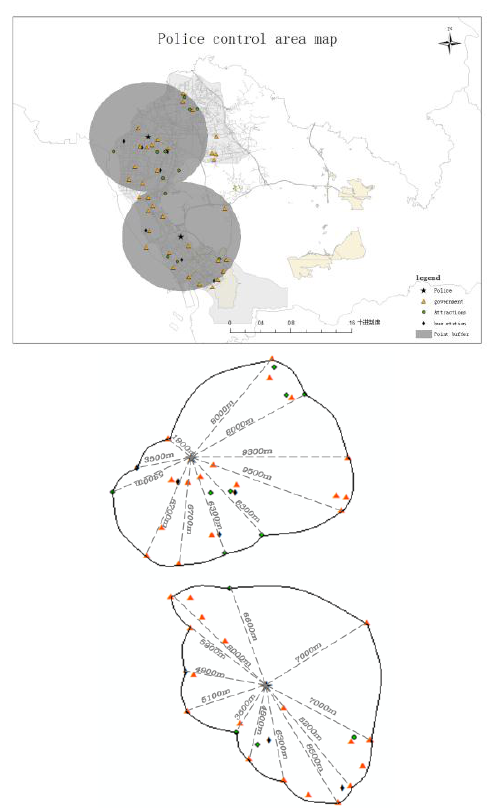
Figure 5. Point buffer comparison chart (a. Traditional buffer; b.Irregular buffer)